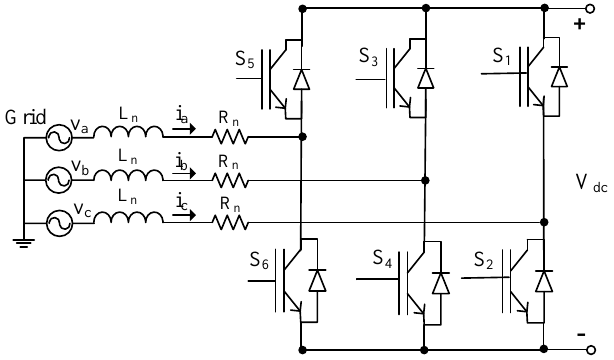
Figure 4. Configuration of the bidirectional AC/DC